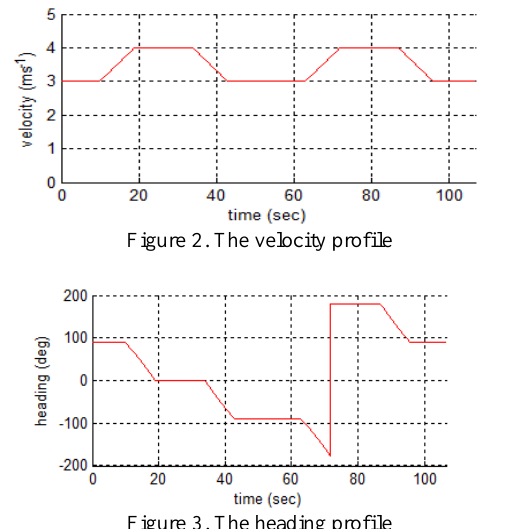
Figure 3. The heading profile